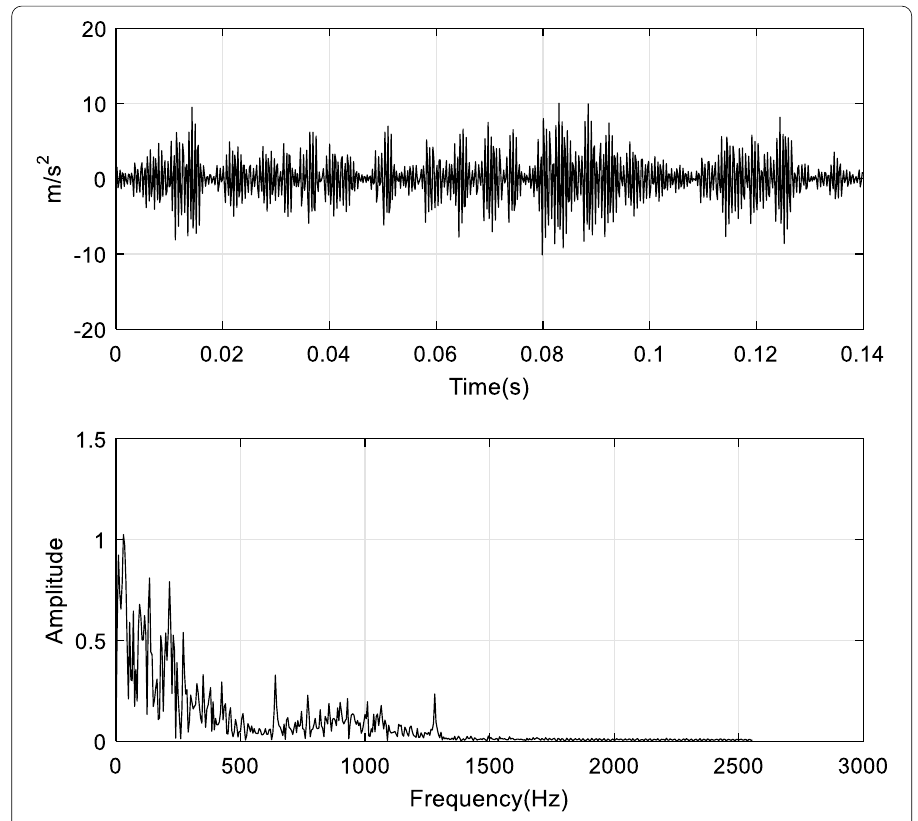
Fig. 15 Waveform and envelope spectrum of characteristic sub-band signal extracted by